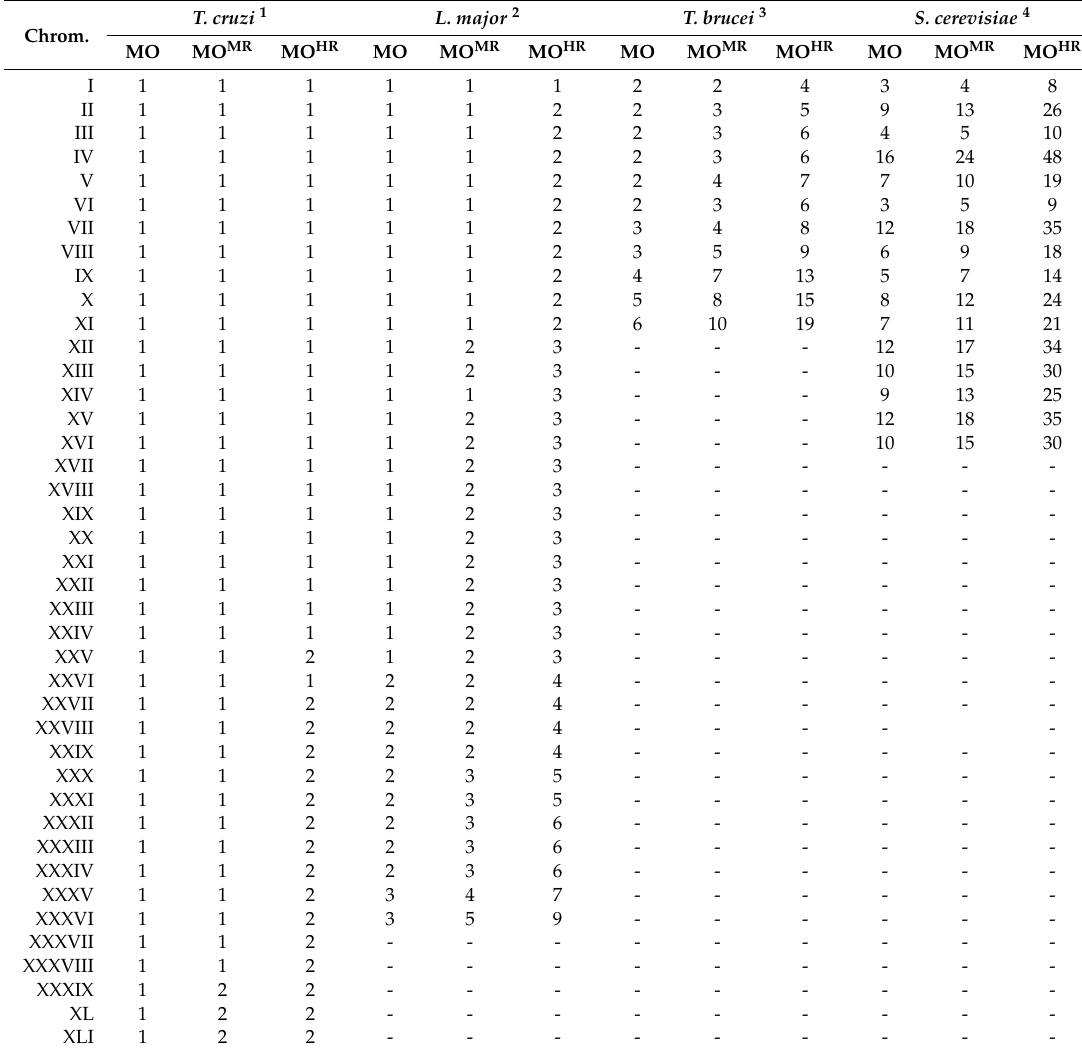
Table 2. Calculation of the minimum number of origins (MO) per chromosome in the presence of mild (MO MR ) and harsh (MO HR ) replication stress.